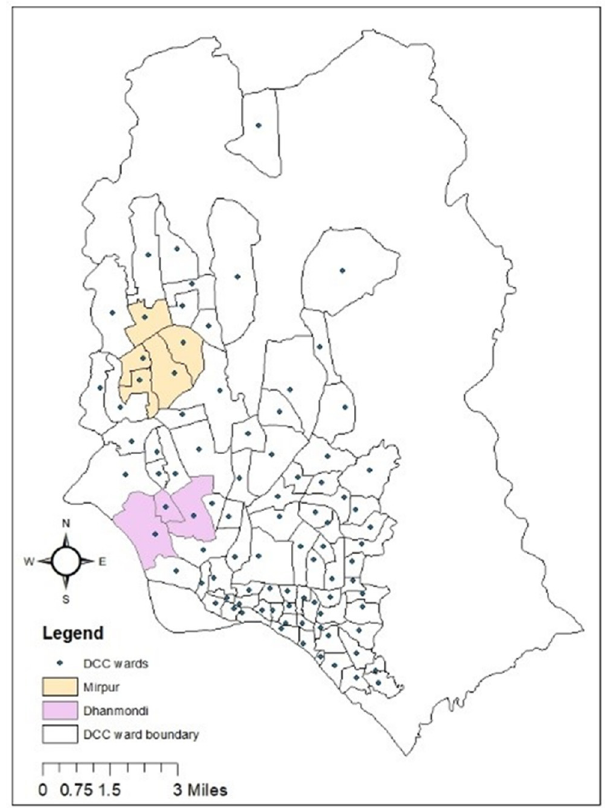
Figure 1. Two study sub-areas: Dhanmondi and Mirpur Thanas in Dhaka Metropolitan Area. Thana: Administrative unit / district containing multiple wards controlled by one specific police station. Ward is a smaller administrative unit representing municipality for electing representatives in local level. DCC: Dhaka City Corporation.